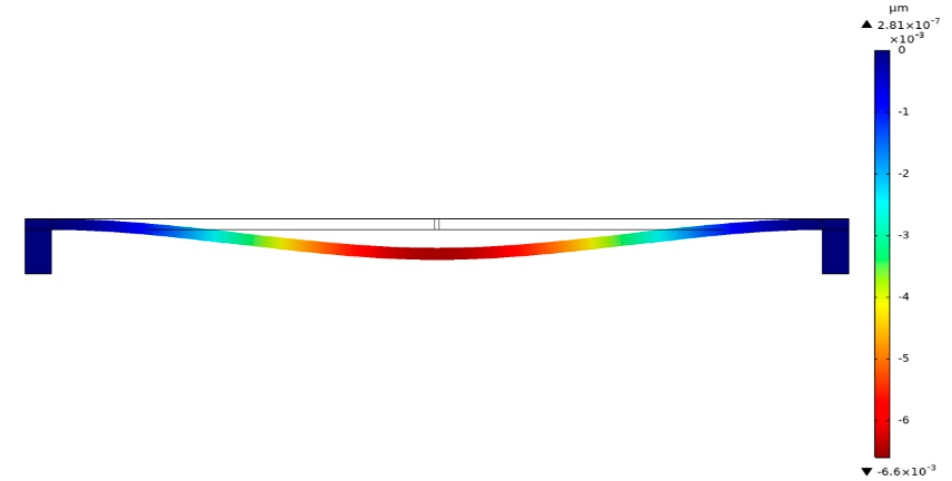
Figure 3. The deflection of a center − loaded doubly clamped beam.